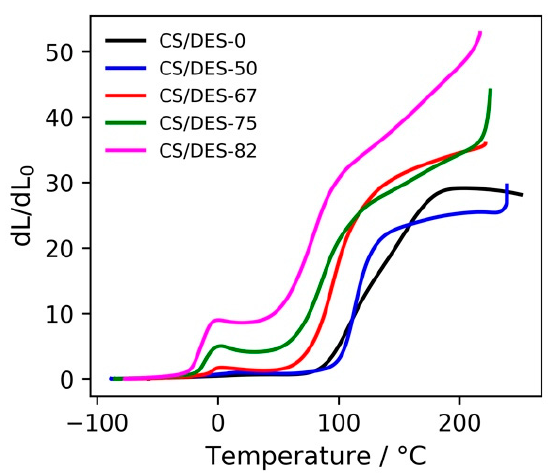
Figure 8. TMA curves for CS—LA film (CS/DES-0) and films with different NADES contents (50, 67, 75 and 82 wt%).